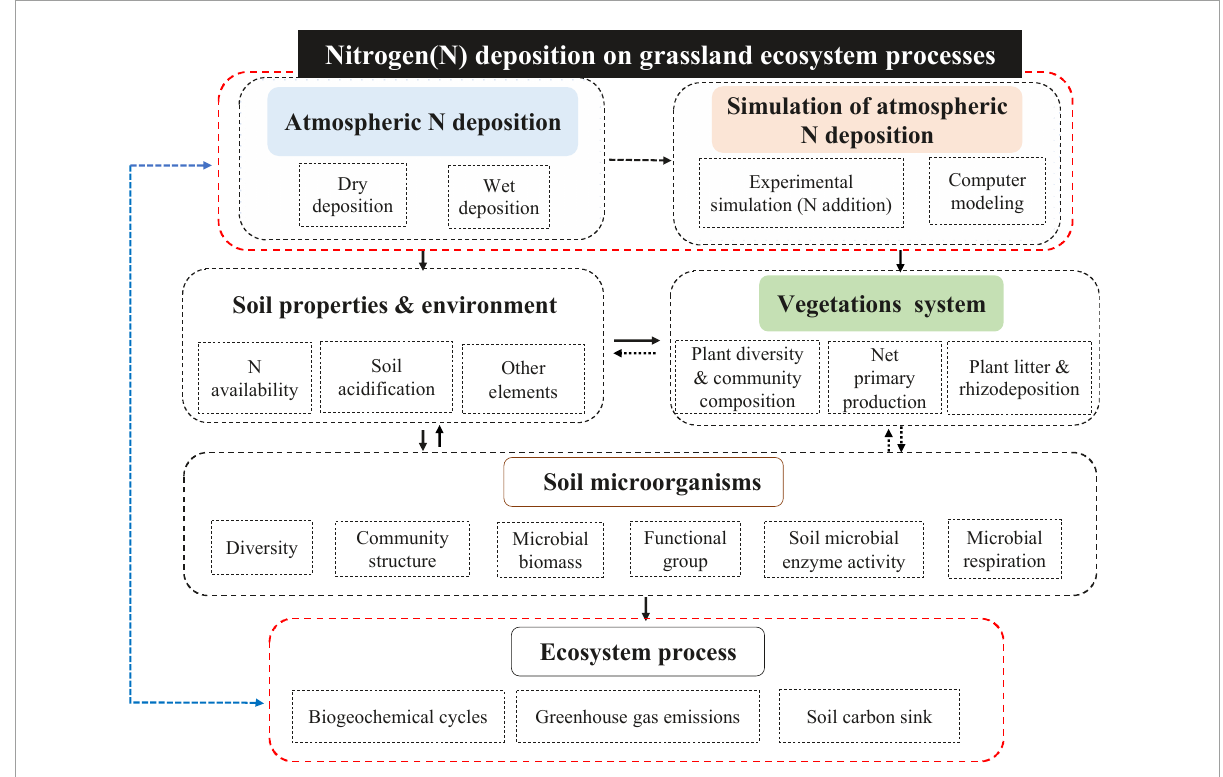
FIGURE1 Conceptual diagram of the ecological effects of N deposition in grassland ecosystems. Nitrogen deposition can be divided into atmospheric nitrogen deposition (dry deposition and wet deposition) and artificially simulated nitrogen deposition (artificial addition experiments and computer simulations). The main impacts on grassland ecosystems include soil systems, plant systems, and ecosystem processes, with soil microorganisms in turn playing an important role as drivers affecting the soil-plant-ecological process continuum.